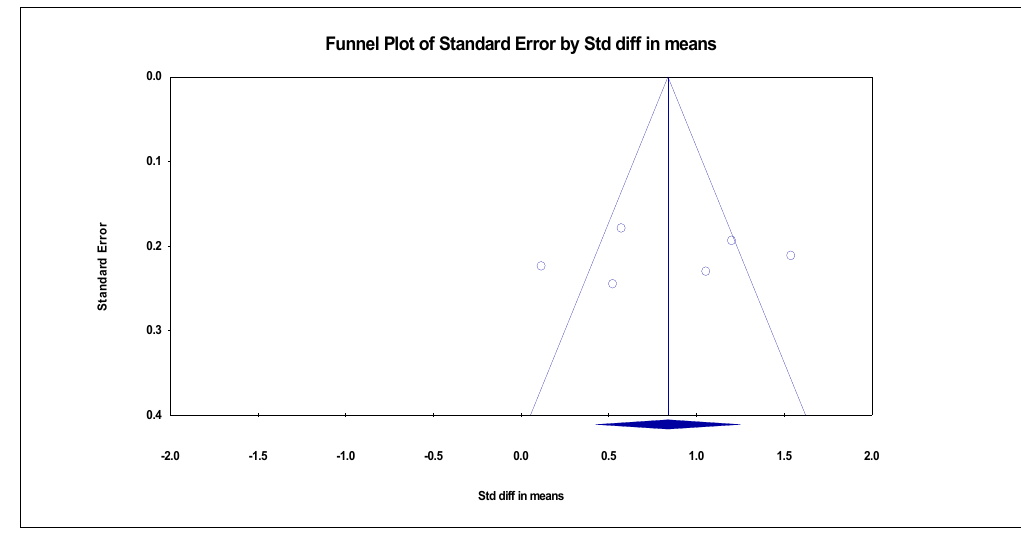
Figure 3. Funnel plot of BDI ‐ II effect of MBCT on depression.